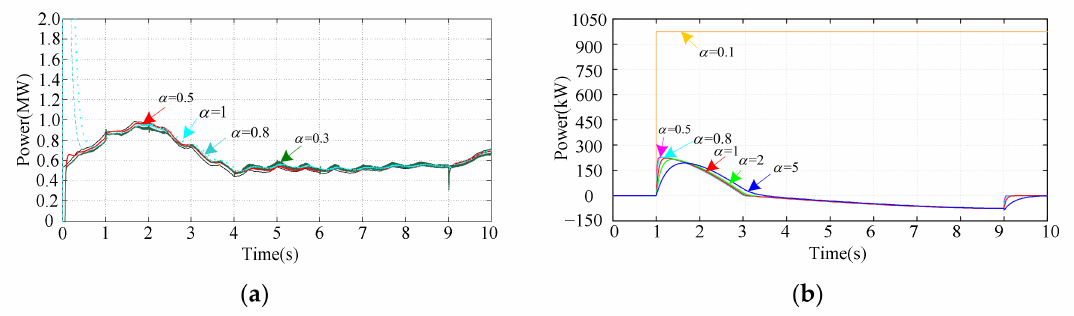
Figure 6. Comparison of DFIG mechanical input power estimation with ESO under different parameters: ( a ) comparison of estimation with ESO-A under different α ; ( b ) comparison of estimation with ESO-B under different α